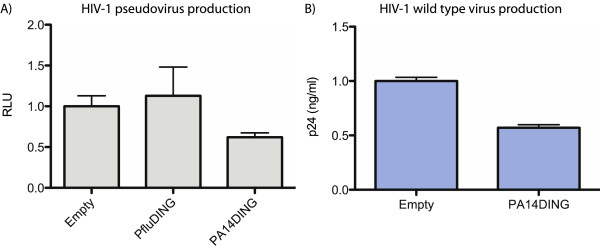
The effect of DING proteins on HIV-1 production in microglial cells. A) Microglial cells were transfected with the pNL43 HIV-1 ∆env pseudovirus genome (30 ng) and DING expression vectors (935 ng). The cell lysates were assayed for luciferase activity 48 hours post-transfection. PA14DING reduced HIV-1 replication by ~40% (p < 0.05). PfluDING did not have a significant effect. This graph is representative of at least three separate experiments. Error bars represent standard error. RLU: relative light units. B) Microglial cells were transfected with the full genome of wildtype HIV-1 strain pNL43 (30 ng) and PA14DING (970 ng). Viral production was determined by measuring levels of the viral capsid protein p24 in the conditioned medium by ELISA 48 hours post-transfection. Serial dilutions of recombinant p24 were used to plot a standard curve which was used to determine the absolute amount of p24 in the conditioned media. PA14DING inhibited HIV-1 replication by ~43% (p < 0.05). The graph is representative of two separate experiments. Error bars represent standard error.